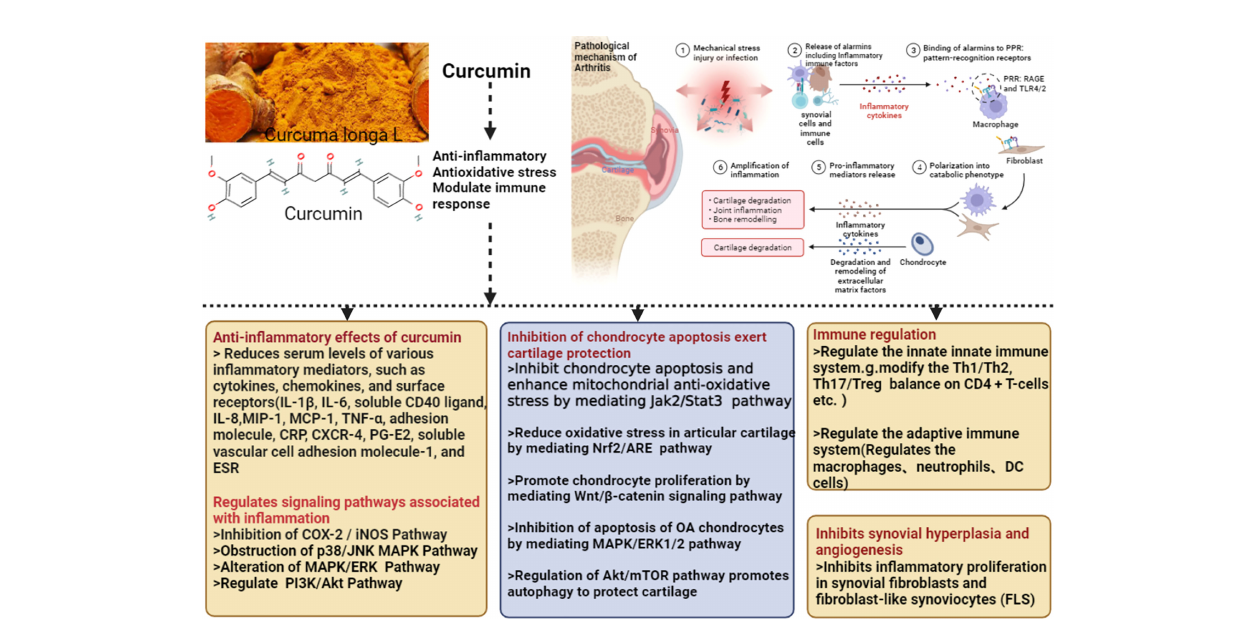
FIGURE 14 | The mechanism of Curcumin and Curcuma longa Extract in the treatment of